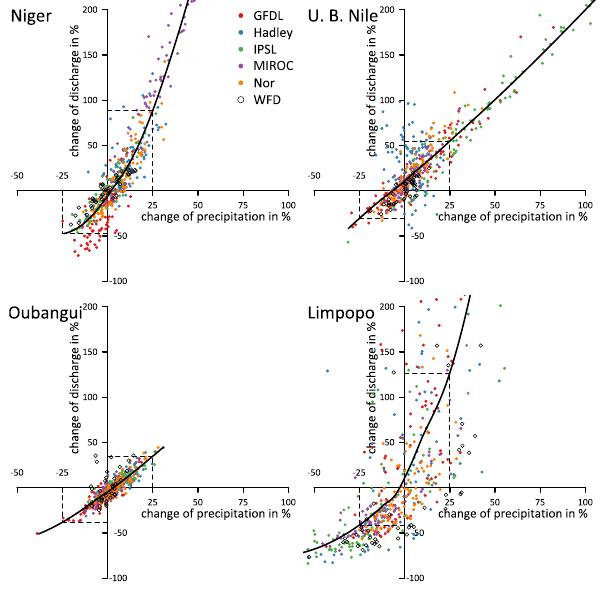
Fig. 7. Climate sensitivity in the four basins. Change in modelled annual discharge [percent] per change of precipitation [percent] for 2006–2099 compared to the mean of base period 1970–1999 for five climate models in RCP 8.5 and WFD. Curve shows fitted local regression over all values.